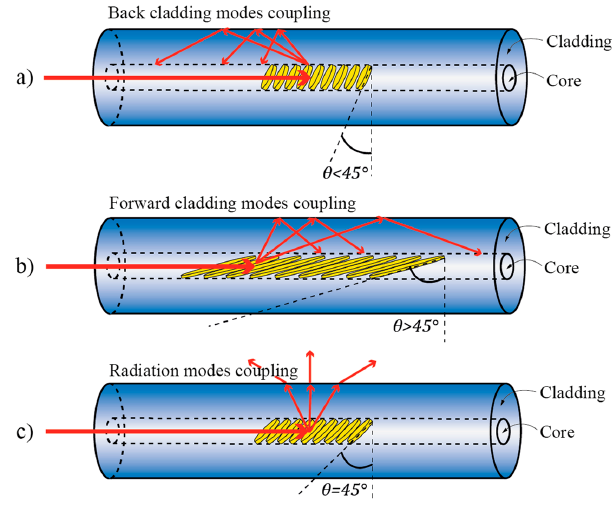
Figure 20. Feasible arrangements for forward and backward coupling of cladding modes in TFBGs. ( a ) Back cladding modes coupling; ( b ) Forward cladding modes coupling; ( c ) Radiation modes coupling.